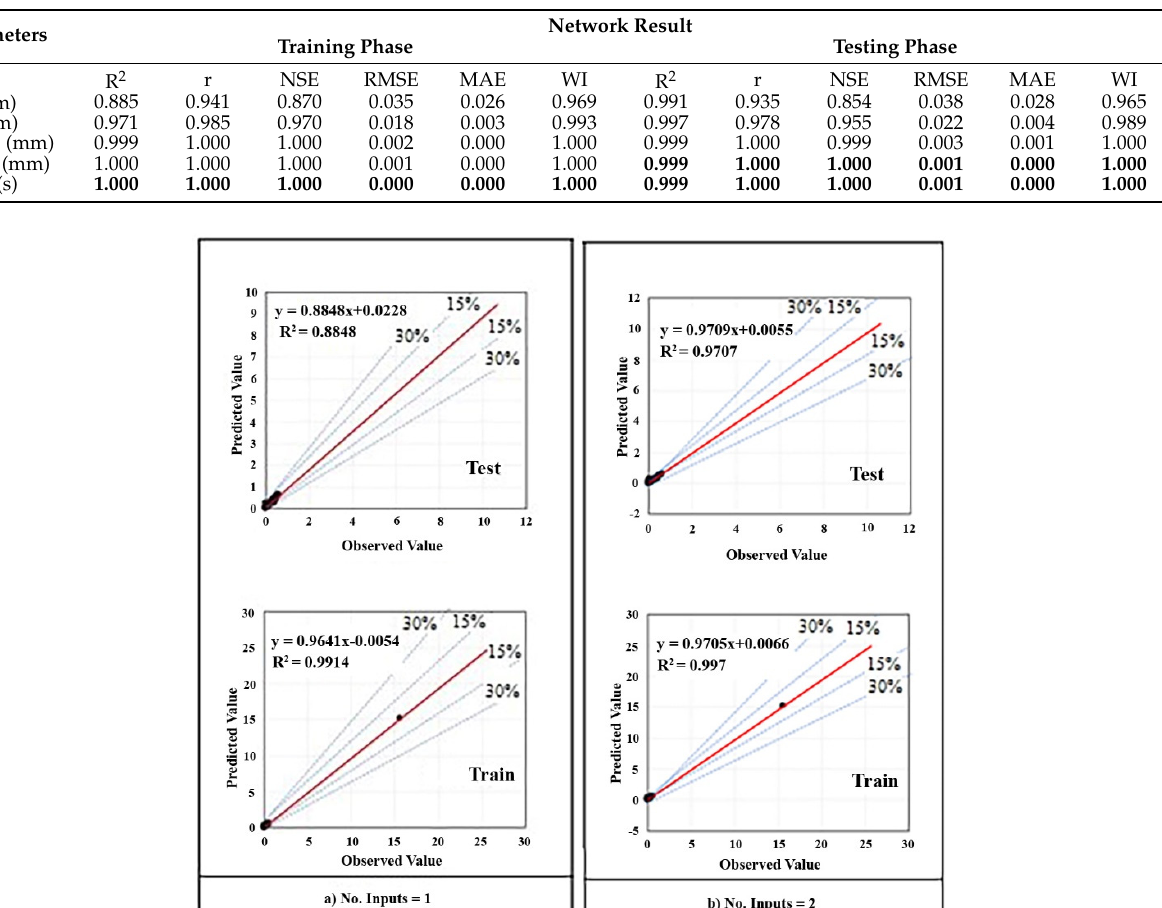
Table 8. Details of the input and output variables.